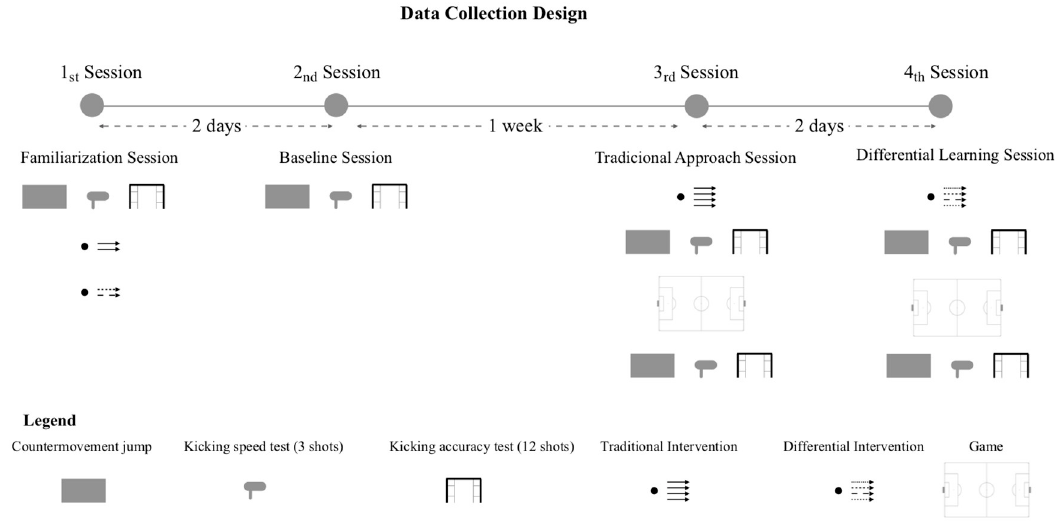
Fig 1. Representation of data collection